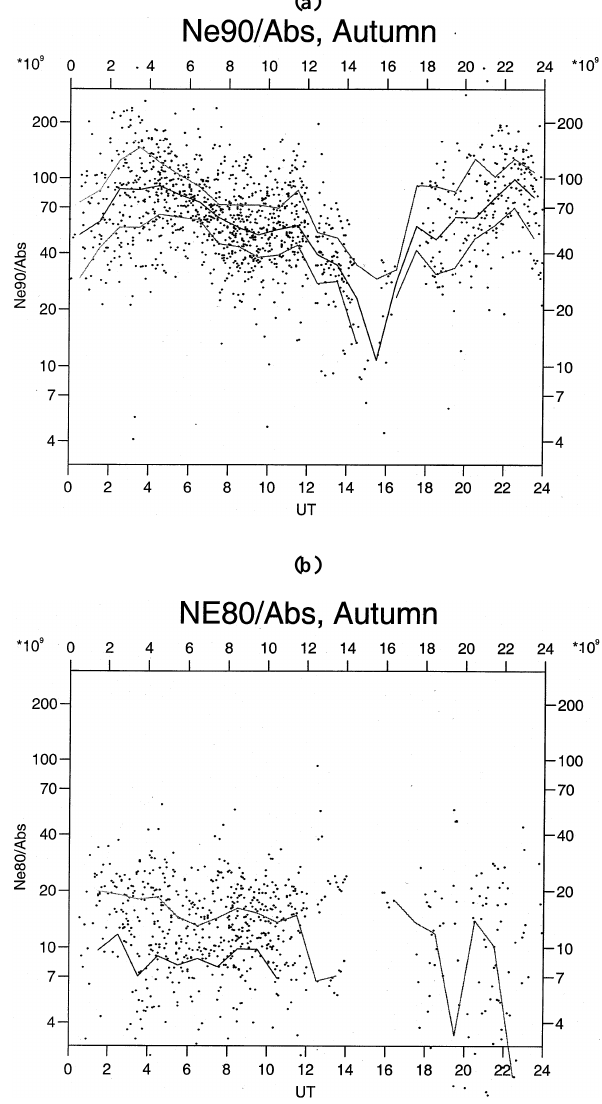
Fig. 1. (a) Value of 90km electron density corresponding to 1dB absorption for the whole data set between 1985 and 1992. (b) Distribution of data points with month and time of day.